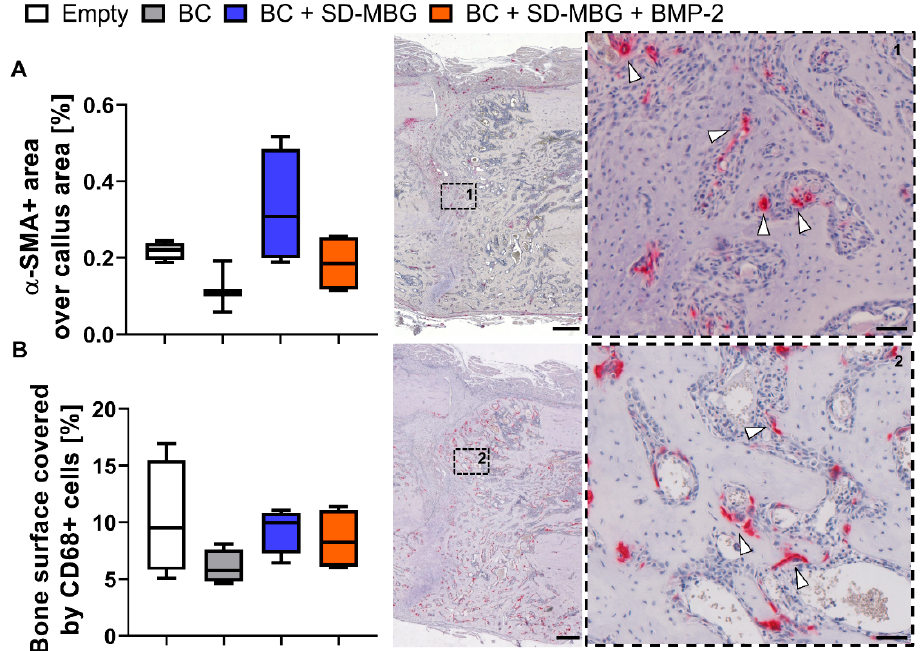
Figure 7. Immunohistochemical (IHC) analysis of rat femora at four weeks post-osteotomy in the osteotomy gap area for α -smooth muscle actin ( α -SMA) ( A ) and cluster of differentiation 68 (CD68) ( B ). ( A , B ( left )): Shown are Tukey box plot distributions with line at median; (middle and right panel): exemplary image of the region of interest (overview, 10 × ) as well as magnified image (40 × , dashed box) showing the localization of the IHC positive cells for a selected region in the middle of the fracture gap are depicted. Hematoxylin counterstain was used for better tissue visualization (purple / blue). White arrows point at examples of the positive α -SMA + and CD68 + staining (red). ( A ) IHC staining of α -SMA for blood vessel quantification based on α -SMA + area normalized to callus area. ( B ) IHC staining of CD68 for quantification of osteoclastic cells based on the length of CD68 + cell contact to newly formed bone over total perimeter of mineralized callus. n = 4, scale bar = 500 µ m in overview image (middle), scale bar = 50 µ m in magnified image ( right ).